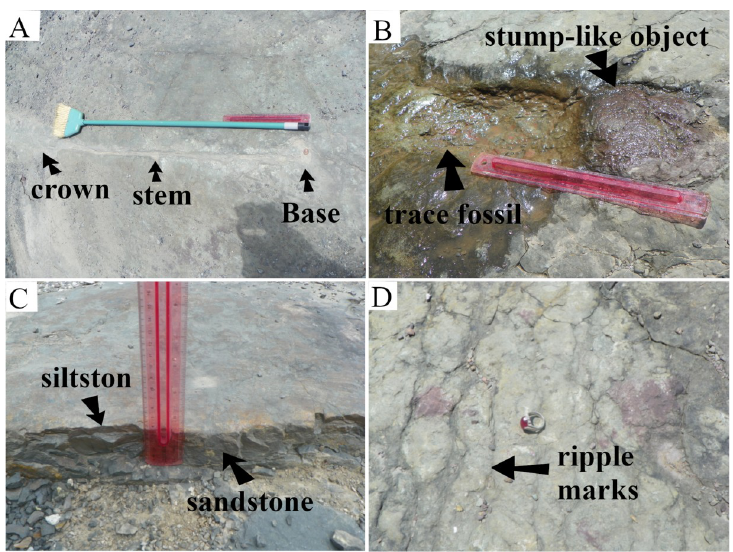
Fig 12. Main features of the A-B section. (A) A washed-in young Eospermatopteris tree. (B) The displaced stump-like object in the form of an oxidized cast and its trace-mark in the form of a mold. (C) Organic-rich, fossiliferous sandstone underlying the siltstone. (D) Small scale ripple marks. Note that the direction of the displacement of the object is southward, and the Eospermatopteris tree northward. Additionally, the redox features of the siltstone are also